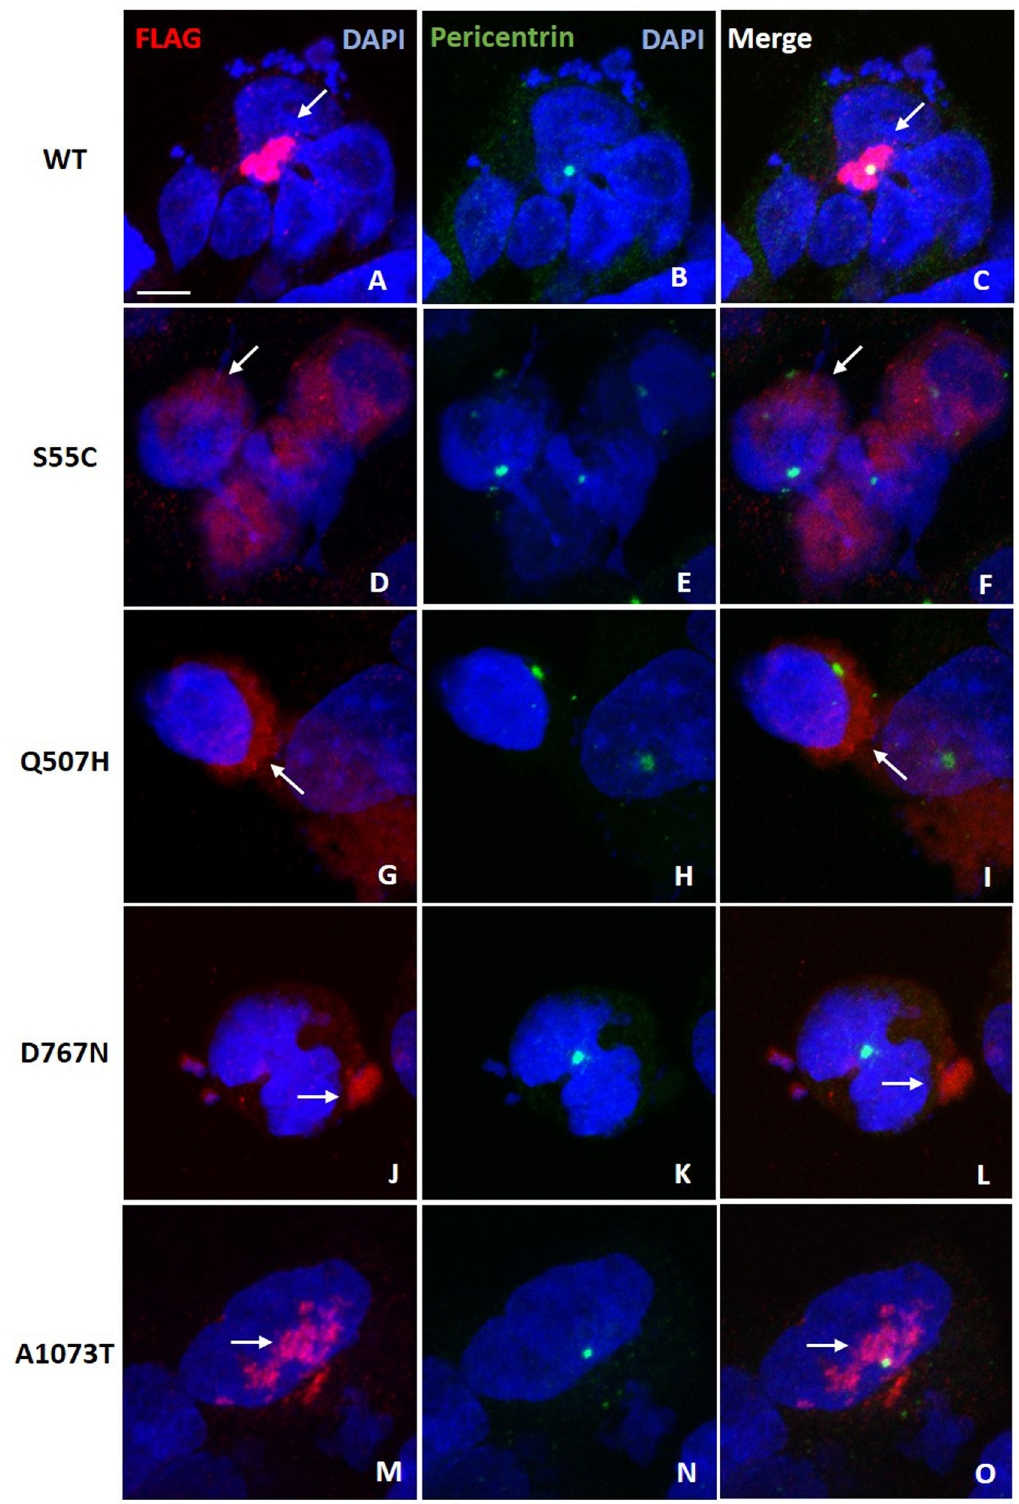
Fig. 3 Abnormal subcellular localization of CCDC141 mutant proteins. Immuno fl uorescence was carried out in HEK293T cells with transient expression of CCDC141, WT ( A – C ), p.Ser55Cys ( D – F ), p.Gln507His ( G – I ), p.Asp767Asn ( J – L ), and p.Ala1073Thr ( M – O ). CCDC141 was stained by anti-FLAG (Red), as indicated by the white arrows. Centrosome was marked by anti-pericentrin (Green). WT wildtype. Scale bar in A (applies to all), 10